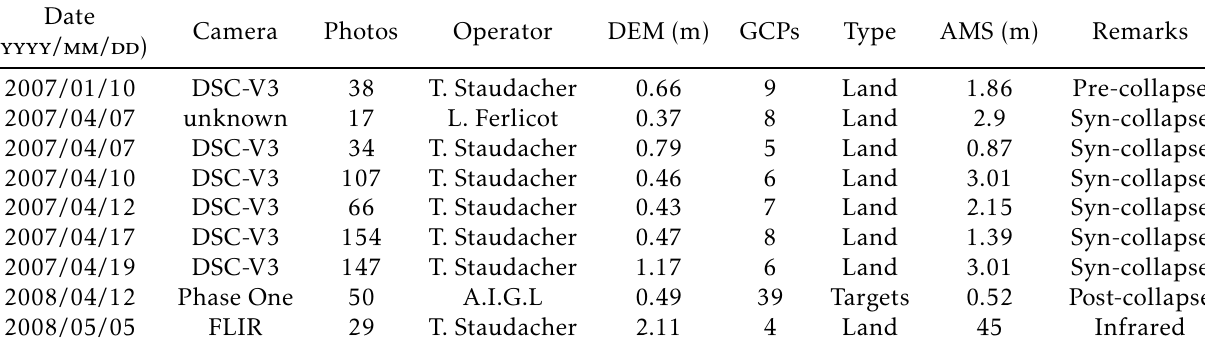
Table 1 – Details of the ultralight airplane aerial photography campaigns (more complete information is available in the Photoscan reports presented in Derrien et al. [2018]) and extracted topographic data used in this study. Photographs: number of photographs in the survey. DEM: resolution in meters. AMS: Absolute Mean Shift, mean absolute georeferencing shift between model and GCPs (as a measure of the georeferencing error [James et al. 2017]. GCP type is ‘land’ when the GCP location has been retrieved on the reference model, and ‘target’ when it has been measured in situ , at the time of acquisition, with GNSS measurements in static-rapid